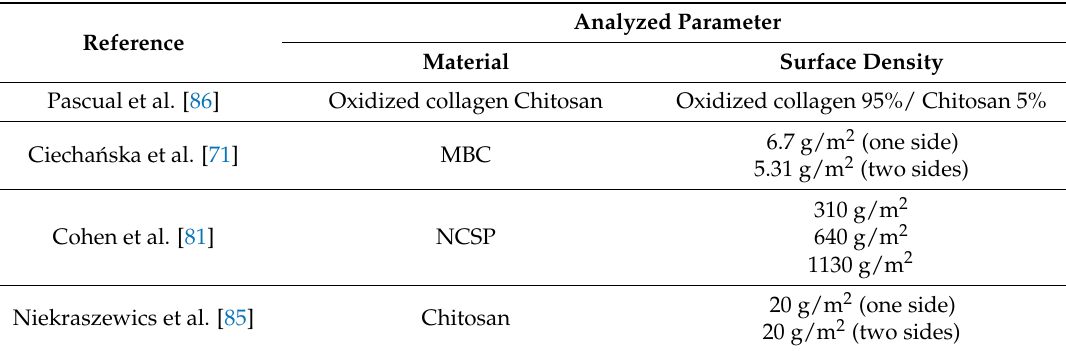
Table 6. Examples of surgical mesh coating